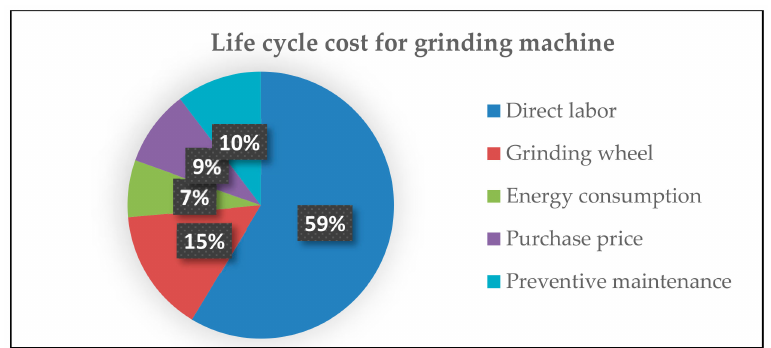
Figure 4. The life cycle cost for a grinding